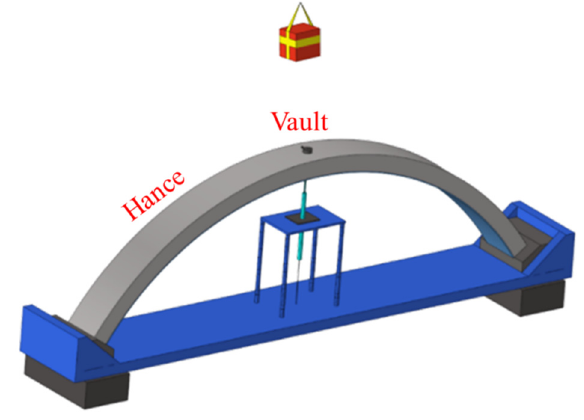
Figure 5. Arrangement of anti ‐ blast experiment. Table 5. Anti ‐ blast test scheme.